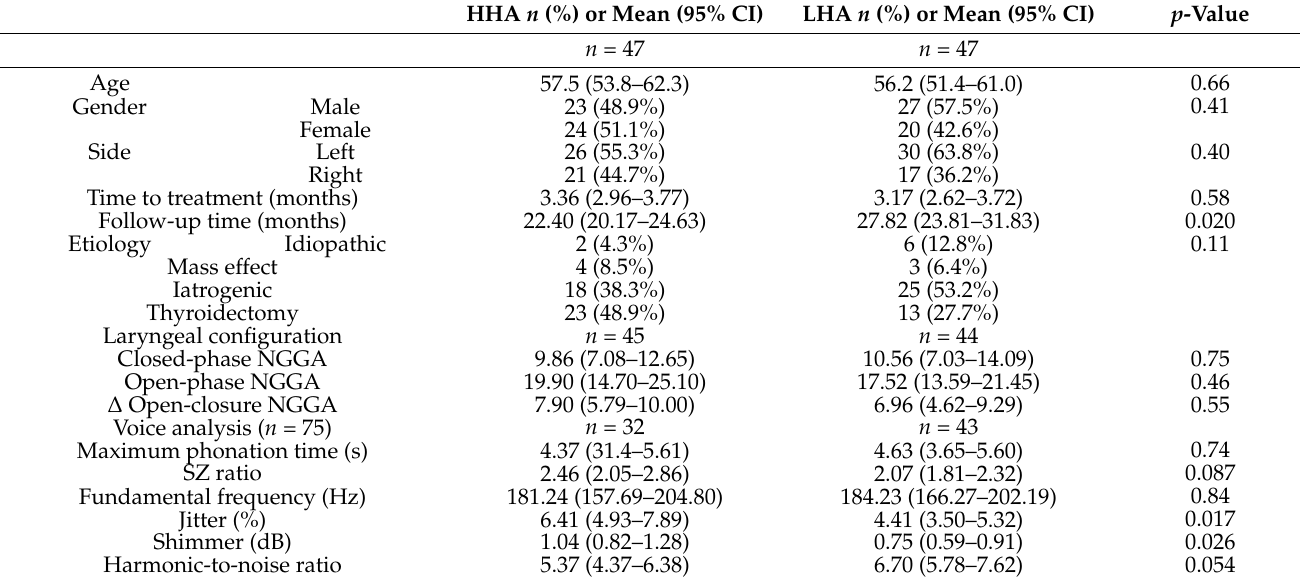
Table 4. Patient demographics between HA groups ( n = 94).